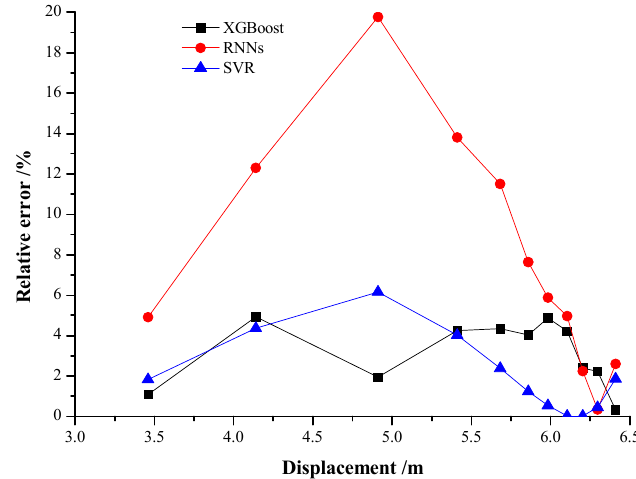
Figure 13. Variation of RE with slope displacement of D7.